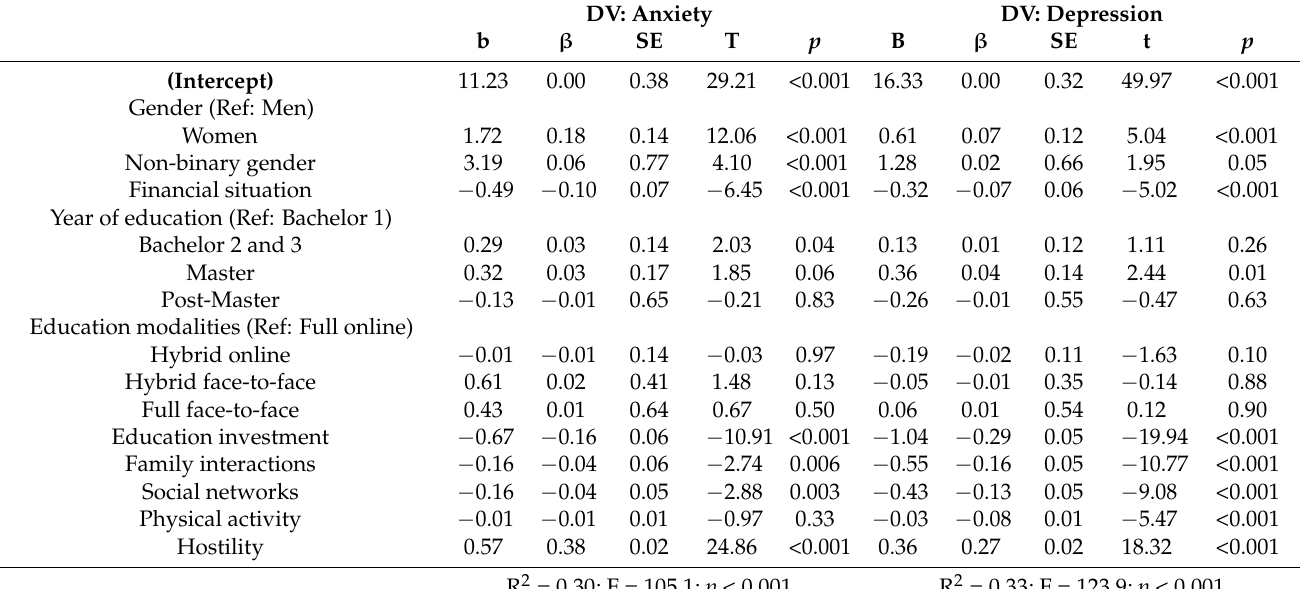
Table 2. Multiple regression—predictive models of anxiety and depression among